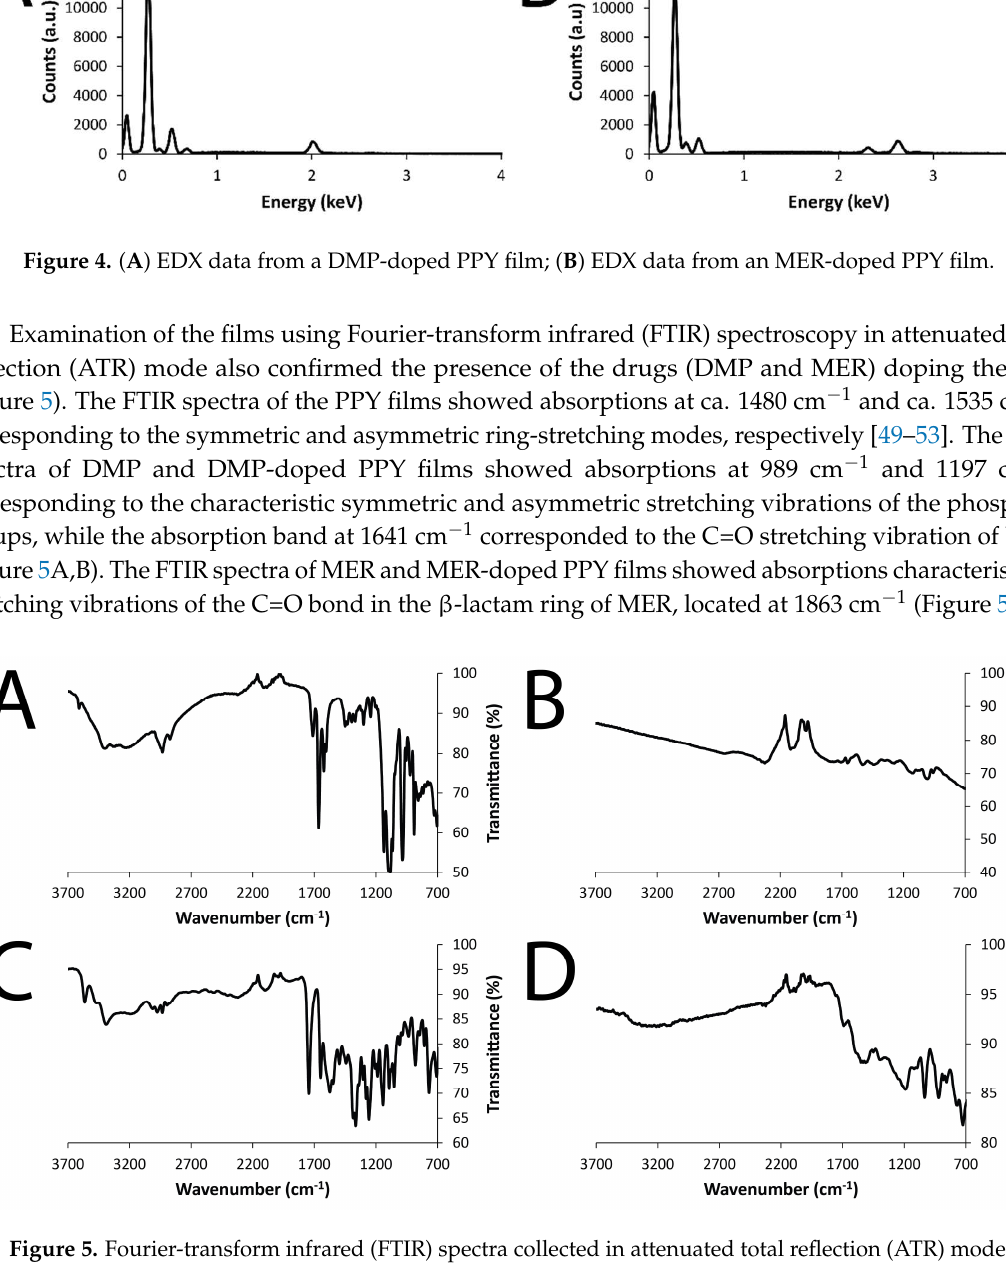
Figure 5. Fourier-transform infrared (FTIR) spectra collected in attenuated total reflection (ATR) mode: ( A ) DMP; ( B ) DMP-doped PPY film; ( C ) MER; ( D ) MER-doped PPY film.